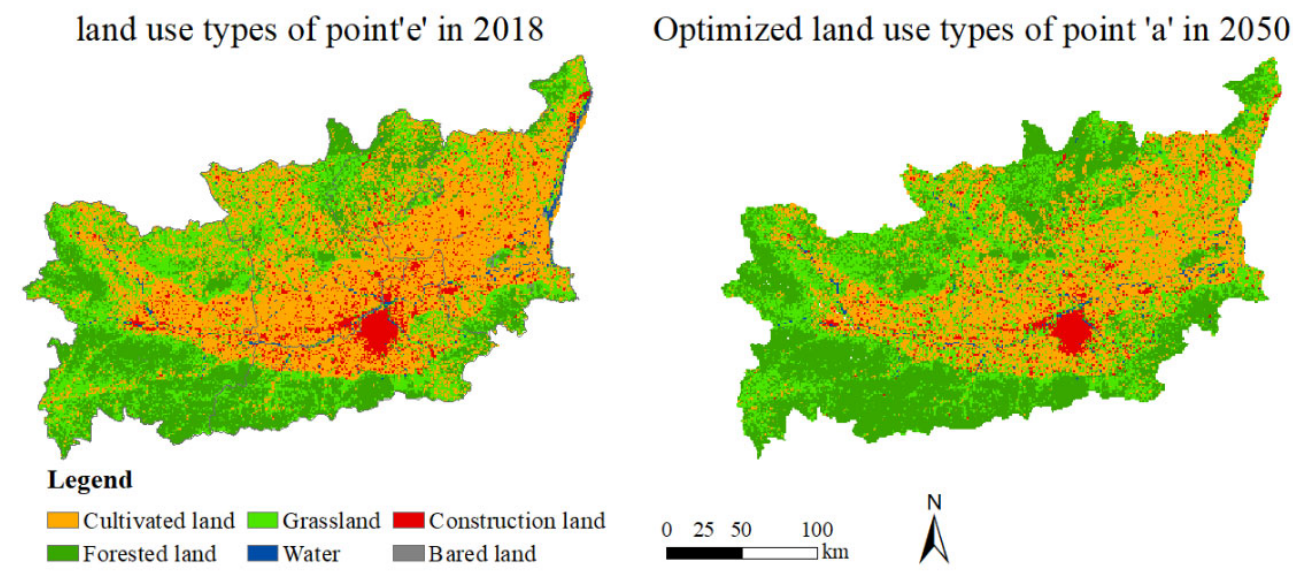
Figure 7. Land use patterns under optimal PPF curves of Guanzhong Region.